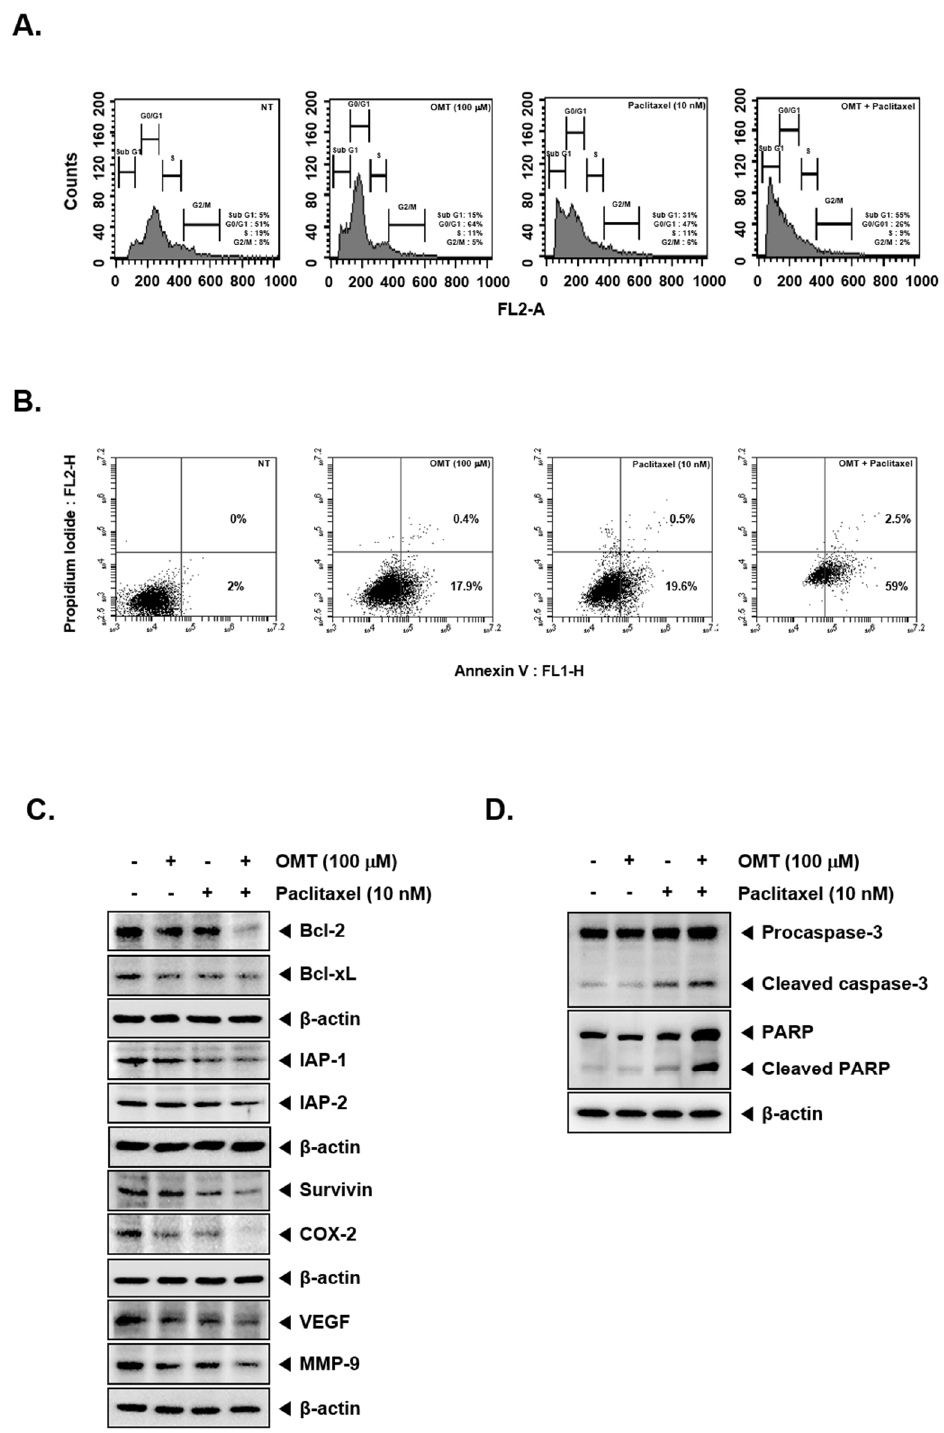
Figure 5. OMT and paclitaxel can induce substantial apoptosis. ( A ) A549 cells (5 × 10 5 cells/well) were treated with OMT (100 μ M) and paclitaxel (10 nM) for 24 h and then incubated with RNase A for 1 h. Cells were stained with propidium iodide, analyzed by flow cytometry. ( B ) OMT (100 μ M)- and paclitaxel (10 nM)-treated A549 cells were stained with Annexin V-FITC and propidium iodide and analyzed by flow cytometry. ( C , D ) A549 cells (5 × 10 5 cells/well) were treated with OMT (100 μ M) and paclitaxel (10 nM) for 24 h. Equal amount of whole cell lysates were analyzed via Western blot analysis for various proteins.